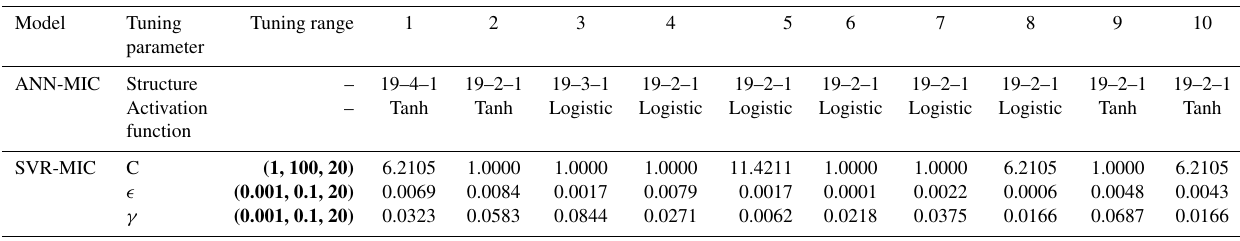
Table 5. Tuning parameters for ANN-MIC and